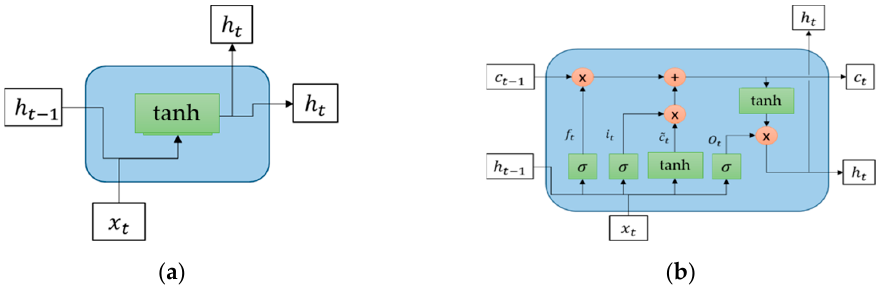
Figure 7. Comparison between simple recurrent neural network (RNN) and long short-term memory (LSTM) layer: ( a ) simple RNN layer, ( b ) LSTM layer.